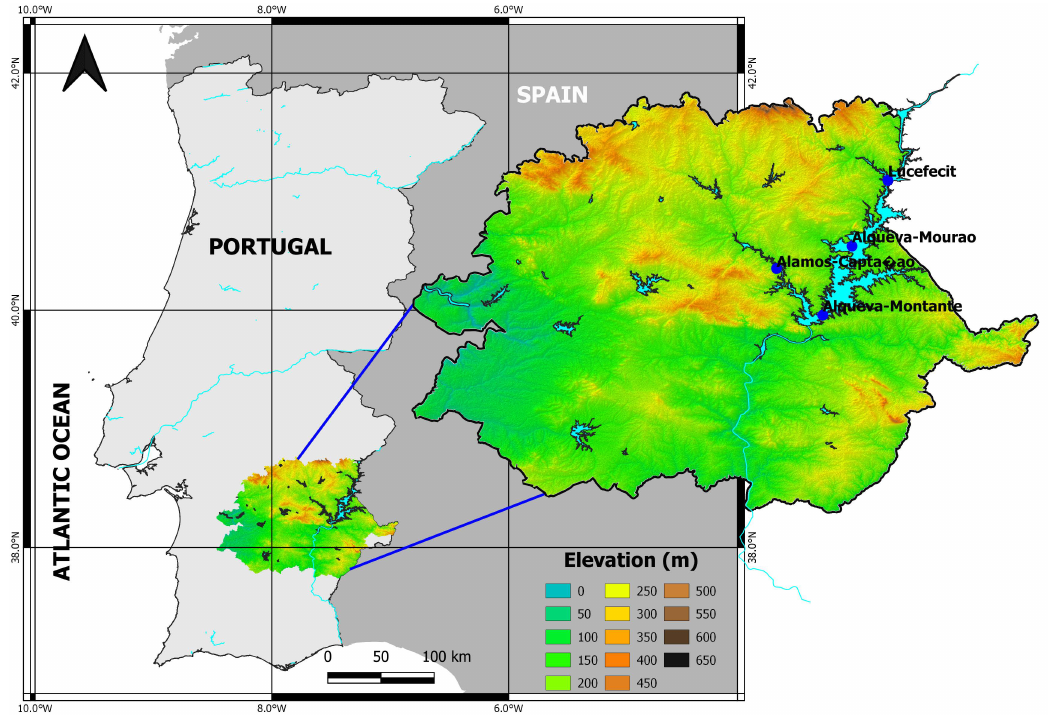
Figure 1. Map showing the location of Inland Alentejo, the Alqueva reservoir, and the sampling